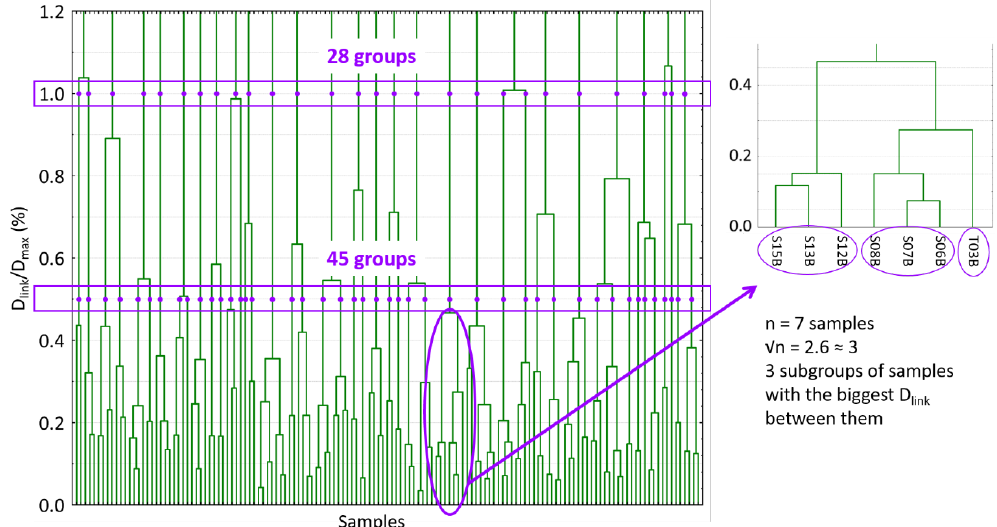
Figure 2. Dendrogram produced in the hierarchical clustering analysis. The two linkage distances and the different groups produced are marked. Moreover, the procedure of selecting different linkage distances; D max : the maximum linkage distance;